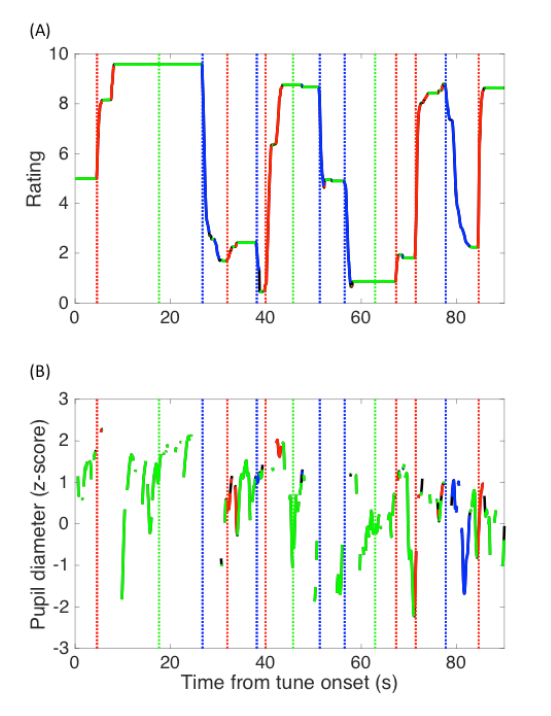
Fig. 5. Examples of on-line surprise rating (A) and pupil size change (B) over time. The lines represent the surprising (red), unsurprising (blue), and the unchanged (green) moments, which were defined as the period when the rating score was increased, decreased, or unchanged over time. The vertical dotted lines represent the reference timing of the surprising change (red), unsurprising change (blue), and unchanged (green)